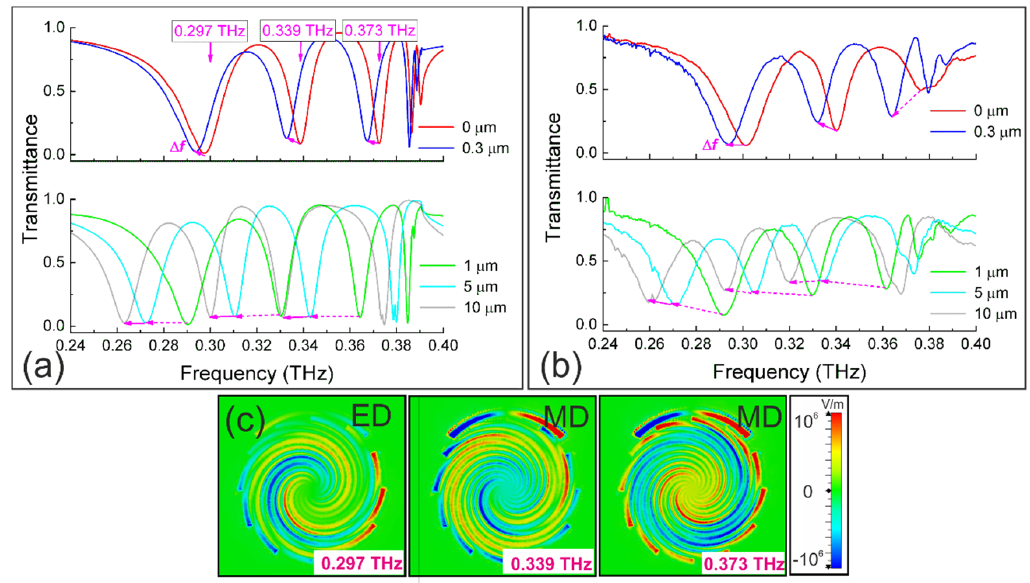
Figure 4. Transmittance spectra of the distantly spaced ( p = 768 µ m) spiral disks with a 90 ◦ C-resonator and photoresist coatings of different thicknesses: ( a ) the numerical simulations; ( b ) the experiments; ( c ) the E Z -field distributions at the resonances (0.297 THz–natural electric dipole mode (ED), 0.339 THz and 0.373 THz–magnetic dipoles (MDs)). Normal incidence ( θ = 0 ◦ ), E || X